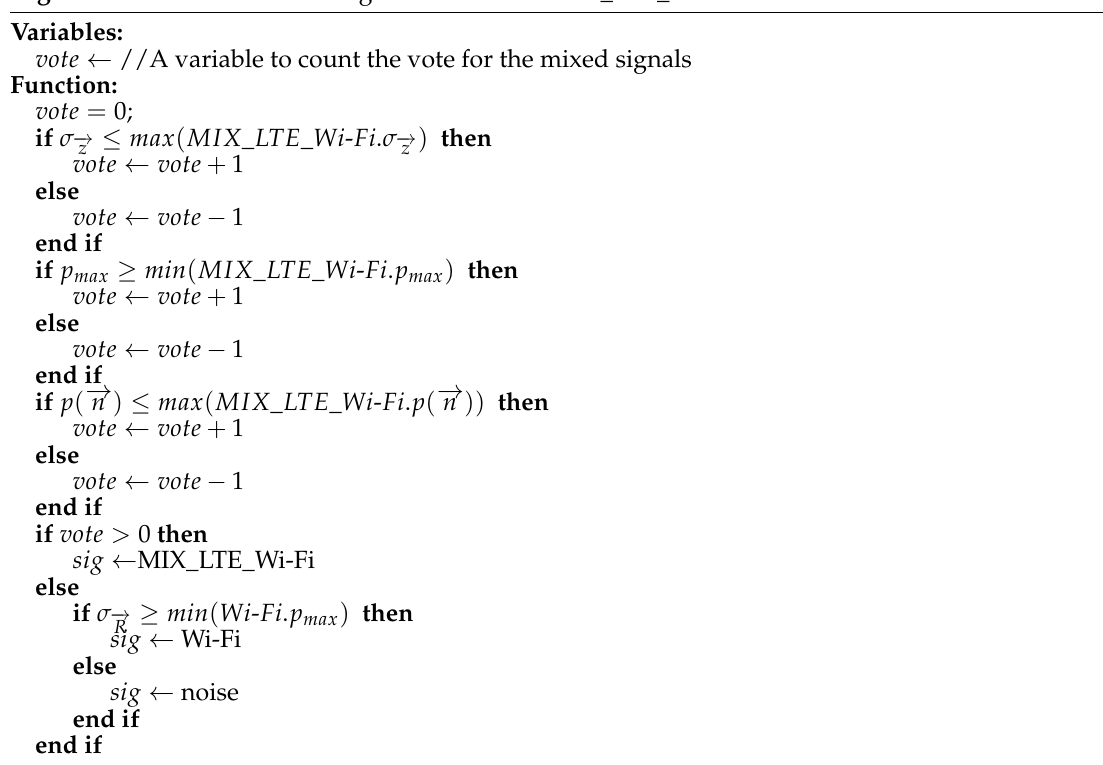
Algorithm 2 Extension to distinguish Wi-Fi from